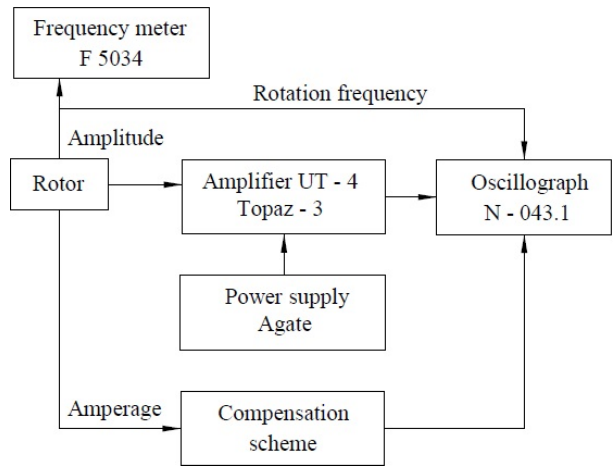
Figure 23. Experimental installation flowchart.